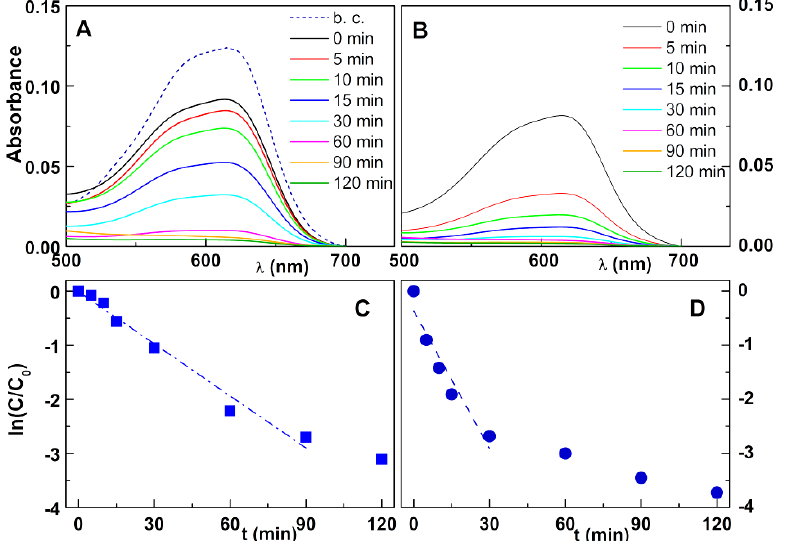
Figure 7. ( A , B ) Photodegradation assays of solutions of the textile dye Reactive Blue 250 (80 mg/L) by zinc/calcium ferrite nanoparticles covered with silver by photodeposition; b. c.: Dye absorption spectrum before adding the catalyst; ( A ) Ferrites prepared by co-precipitation; ( B ) Ferrites prepared by sol–gel. ( C , D ) Plot of the pseudo-first-order kinetics for degradation of Reactive Blue 250; ( C ) Ferrites prepared by co-precipitation; ( D ) Ferrites prepared by sol–gel.